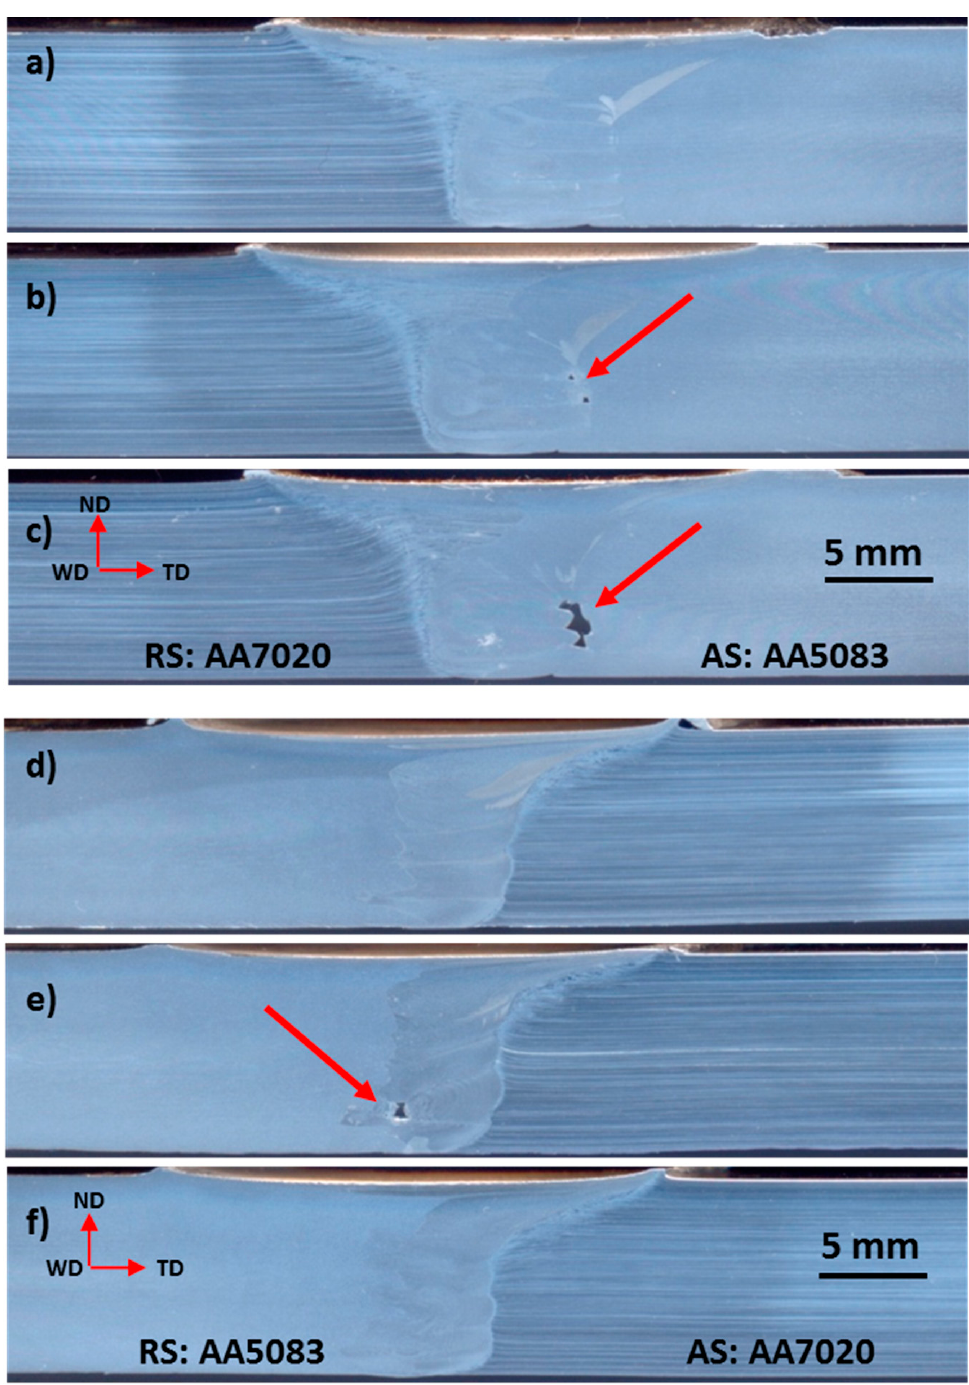
Figure 8. Cross sections of friction stir welded joints at different rotational and traverse speeds for AA5083/AA7020 and AA7020/AA5083 after etching: ( a , d ) 500 rpm, 20 mm/min, ( b , e ) 500 rpm, 40 mm/min and ( c , f ) 500 rpm, 80 mm/min.